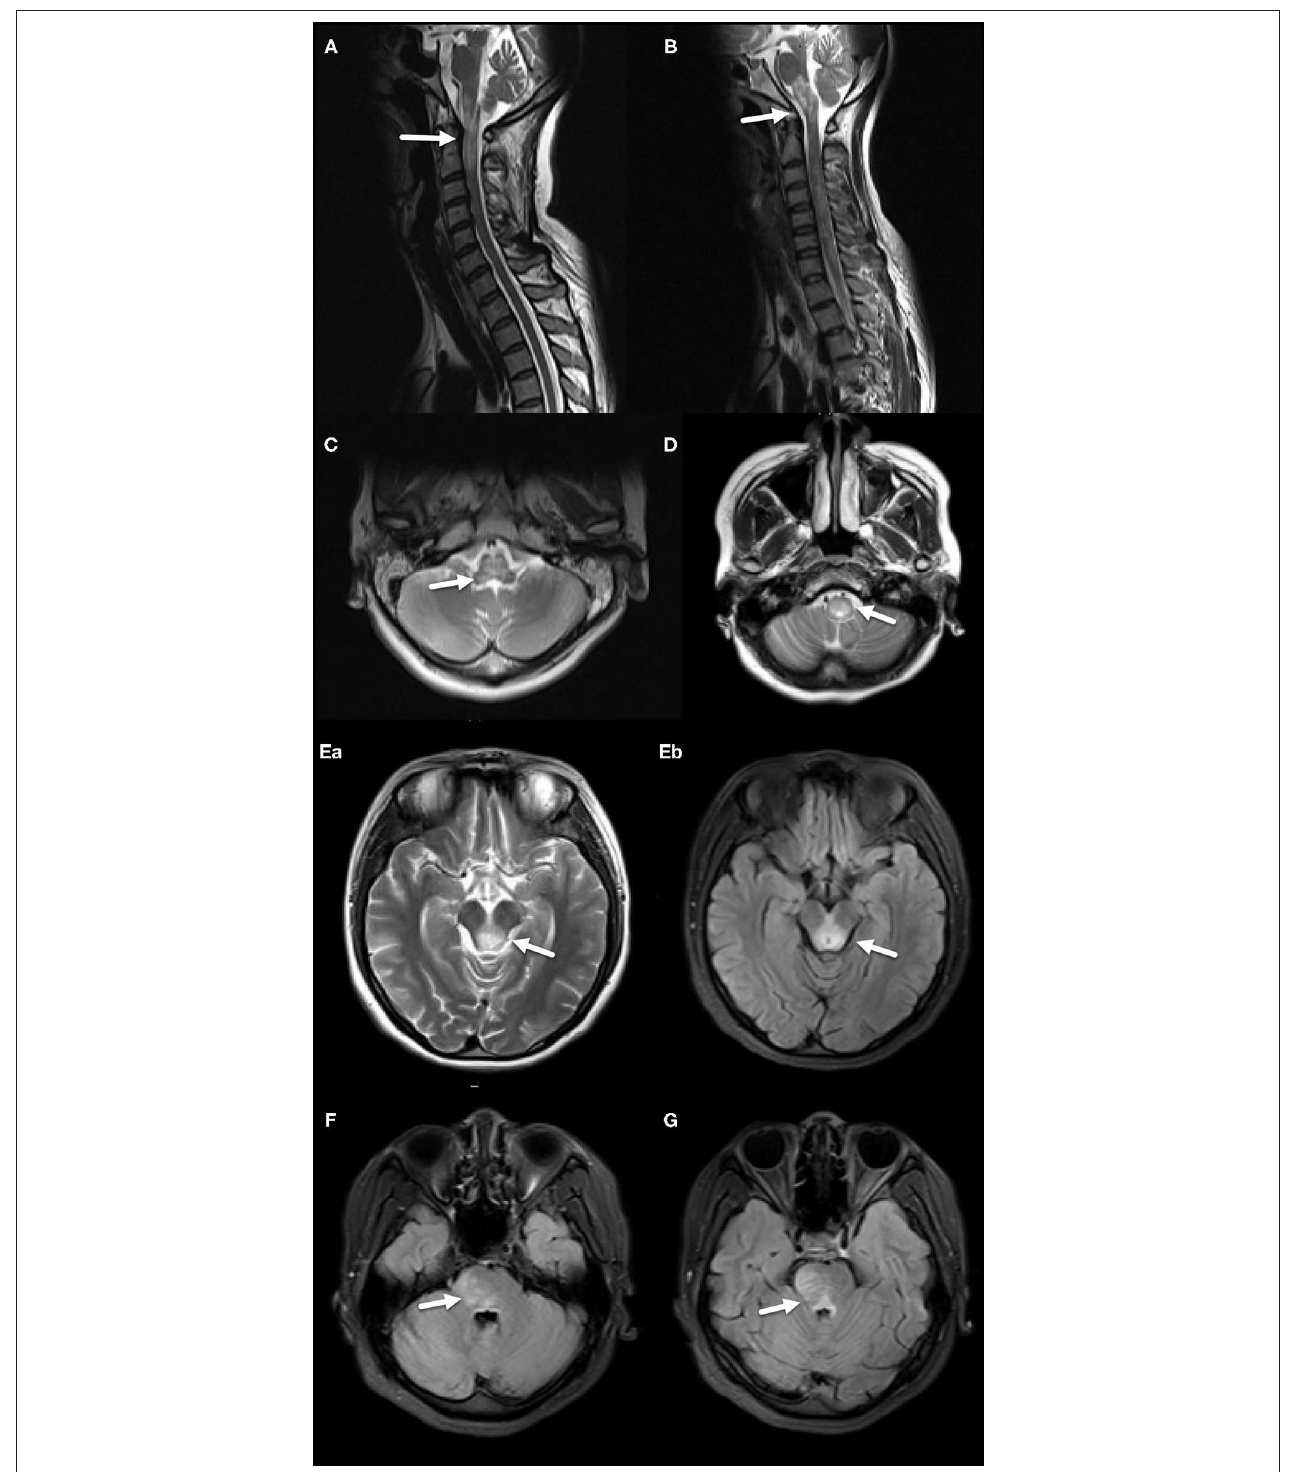
FIGURE 2 | MRI features of the NMOSD group. (A) Diffuse, large abnormal signal extending from the junction of cervical spinal cord and medulla oblongata to the upper cervical spinal cord, including AP, indicated by an arrow. (B) Extensive diffuse, large abnormal signal in medulla oblongata and AP, indicated by an arrow. (C) Large abnormal signal located in central medulla oblongata, indicated by an arrow. (D) Large abnormal signal located in central lower medulla oblongata, indicated by an arrow. ( E –a,b) Large abnormal signal around midbrain aqueduct, indicated by arrows. (F) Large abnormal signal located in pons, indicated by an arrow. (G) Large abnormal signal located in pons and around the fourth ventricle, indicated by an